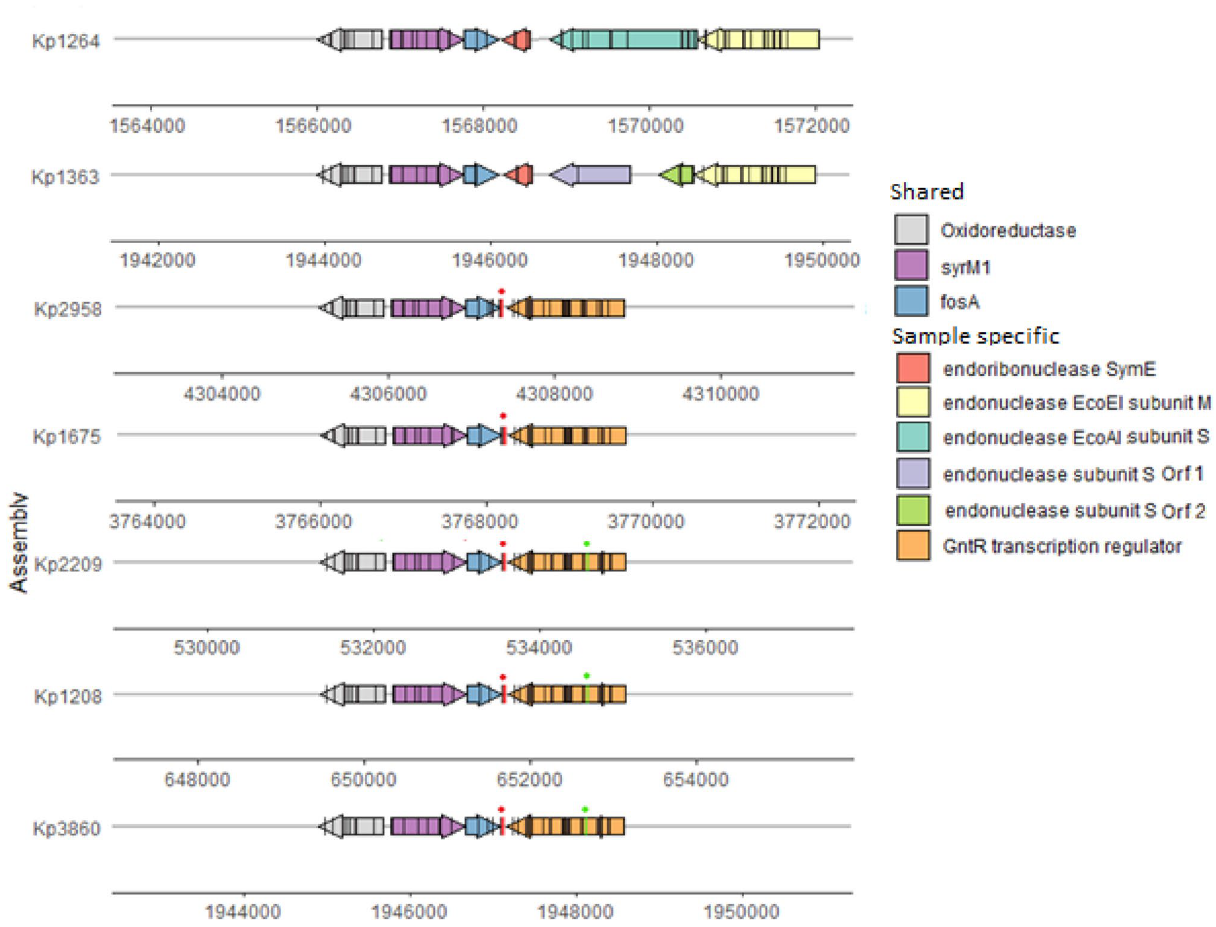
Figure 3. The fosA gene and surrounding region. (Black bars) methylated GATC motifs; (red bars with red dot above) unmethylated GATC motifs downstream of fosA on the same strand; (green bars with green dot above) unmethylated GATC on the opposite strand of GntR family transcription regulator coding sequence. Kp1264 and Kp1363 lack a GATC motif downstream of fosA due to an insertion of endonuclease. The other samples all have a single unmethylated GATC motif downstream of fosA on the same strand as fosA coding sequence. The only other unmethylated GATC in these regions are the motifs on GntR family transcription regulator.